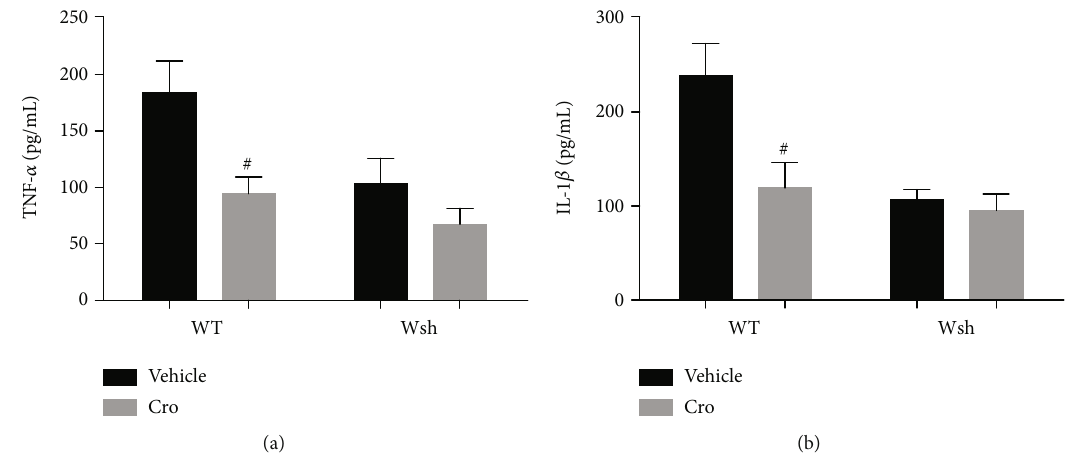
Figure 5: Proin fl ammatory cytokine secretion in the hippocampus was altered by mast cell stabilization and de fi ciency. The levels of TNF- α (a) and IL-1 β (b) were detected by ELISA. # P < 0 : 05 compared with WT vehicle. Data are presented as the mean ± SEM ( n = 5